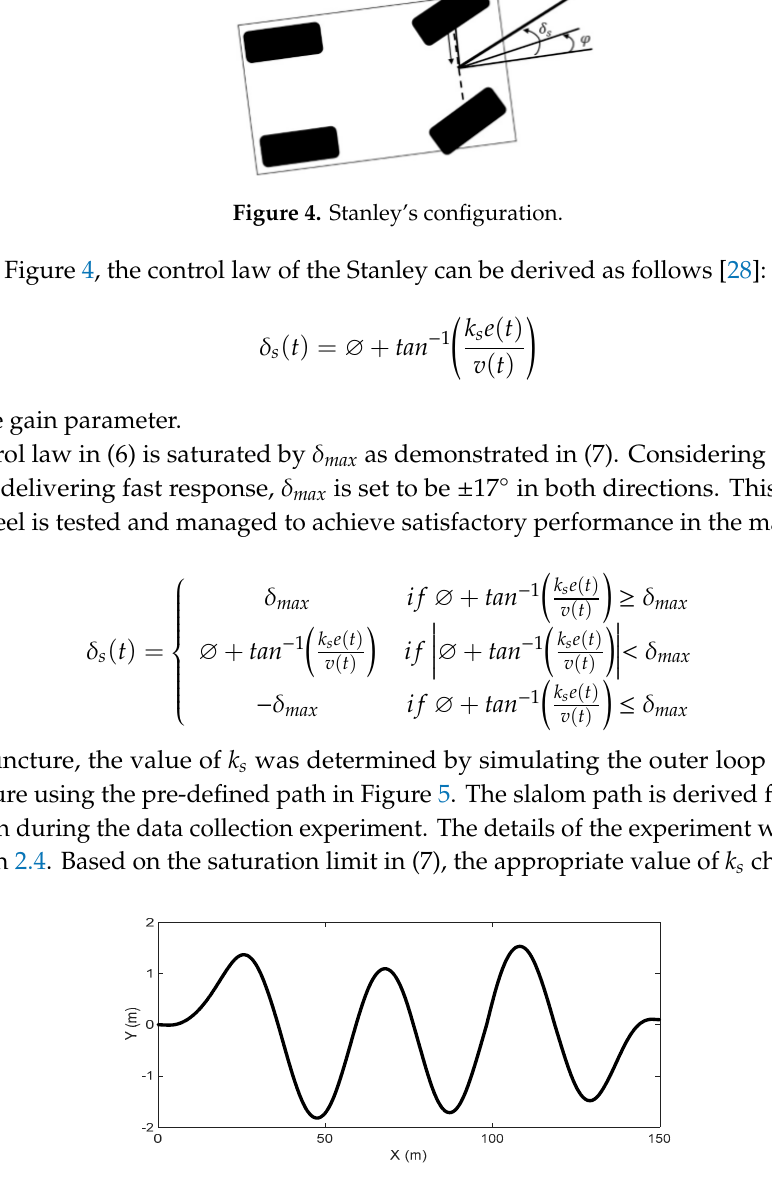
Figure 5. Pre-defined path.